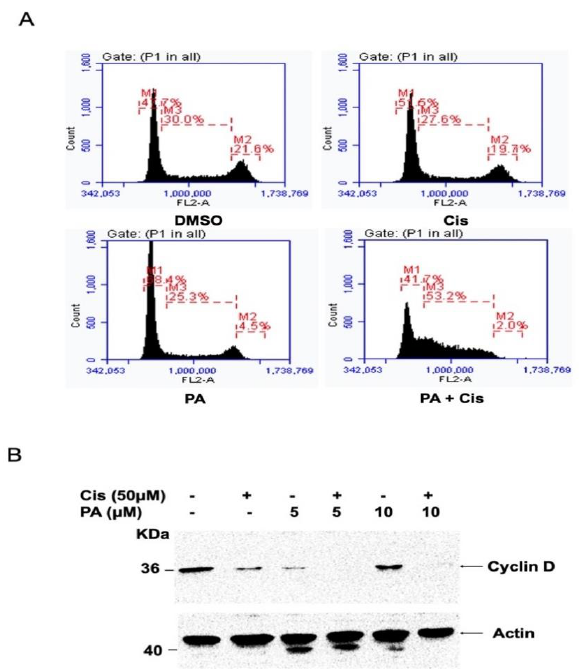
Figure 4. Planispine A-enhanced cisplatin induced apoptosis. ( A ) Fluorescence microscopy images of DAPI-stained cells treated with DMSO (control), cisplatin; cis (50 µ M), planispine A; PA (5 µ M) and combination treatment for 64 h. The red arrows indicate the apoptotic fragmented nuclei (40X). Scale bar, 5 µ m. ( B ) Representative quantification graph for apoptotic nuclei. Data are representative of three independent experiments, n = 3, *** p < 0.001 vs. cisplatin. ( C ) Immunoblot with anti-PARP and anti-caspase-3 after treatment as indicated.